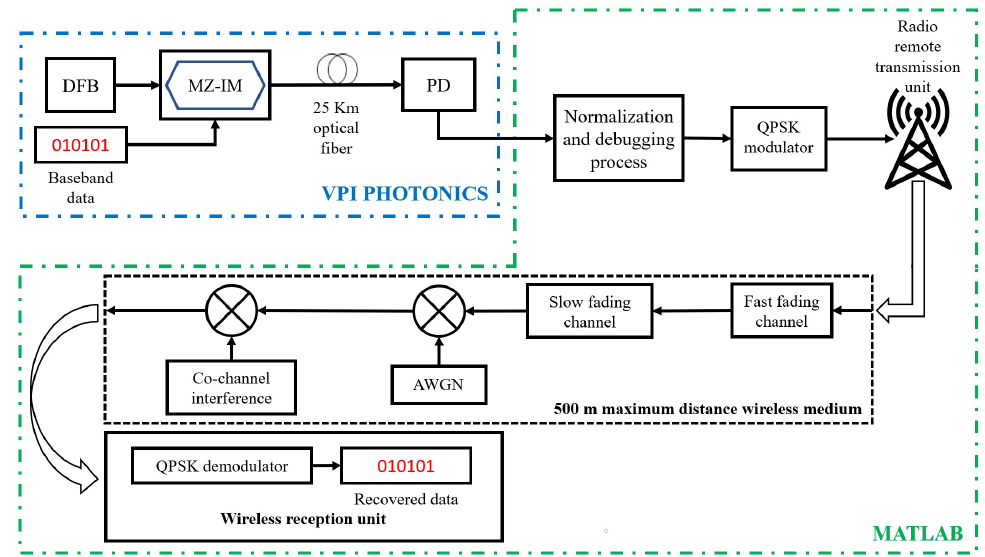
Figure 2. Block diagram of the optical and wireless transmission stages.